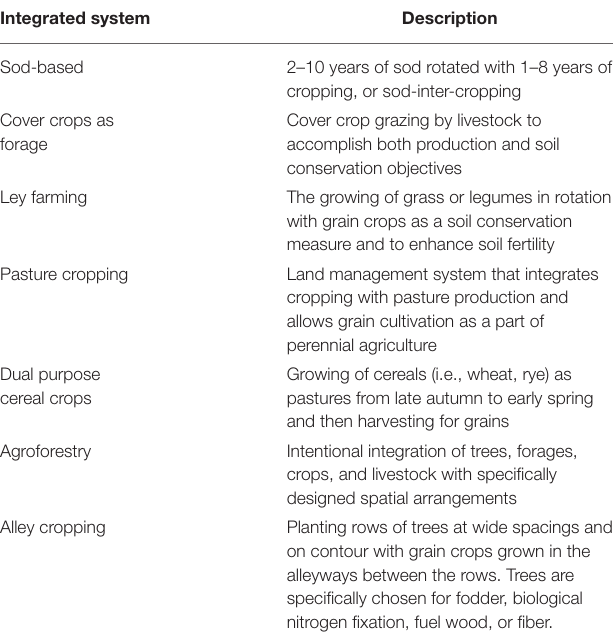
TABLE 1 | Examples of integrated livestock systems with crops and trees (Compiled from Kang et al., 1990; Leakey, 1996; McCown, 1996; Bajracharya et al., 1998; Garrett et al., 2004; Fike et al., 2016; Jose and Dollinger, 2019; Munsell and Chamberlain, 2019; USDA-NRCS,